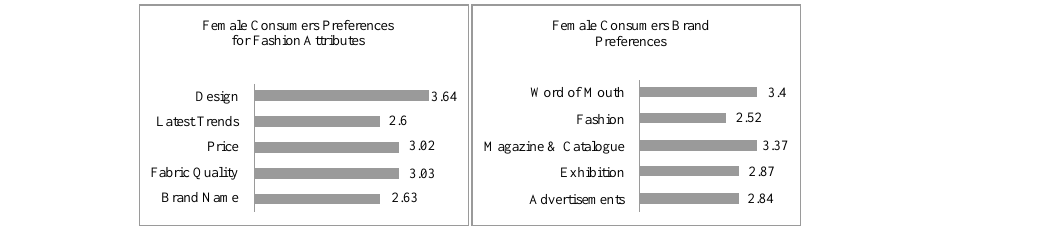
Figure 3: Female Consumer Preference for Brand and Fashion Attributes